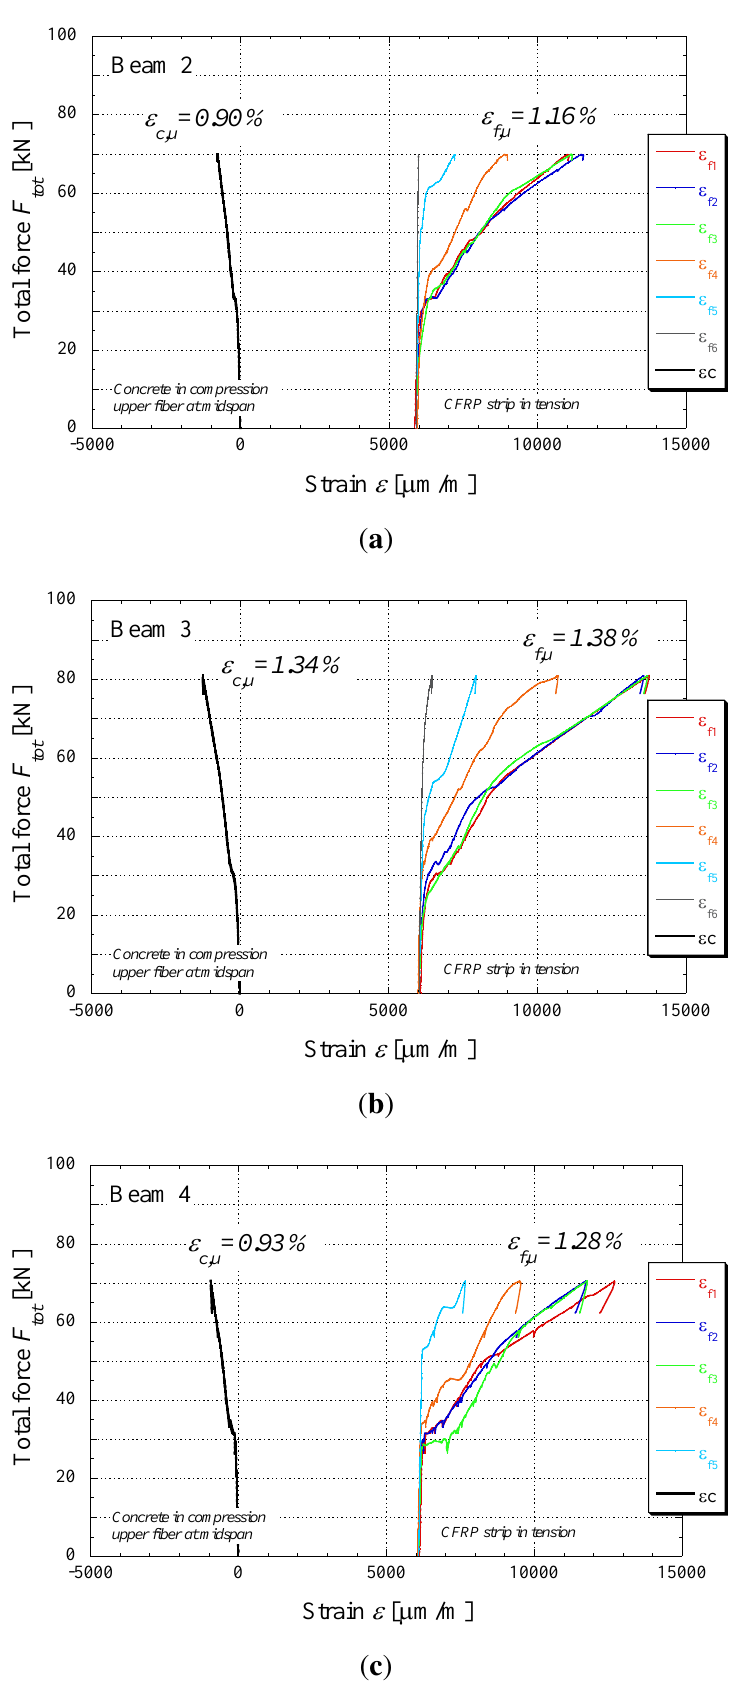
Figure 7. Force-strain curves for the tested beam elements, 2–4. ( a ) Beam 2 force-strain; ( b ) Beam 3 force-strain; and ( c ) Beam 4